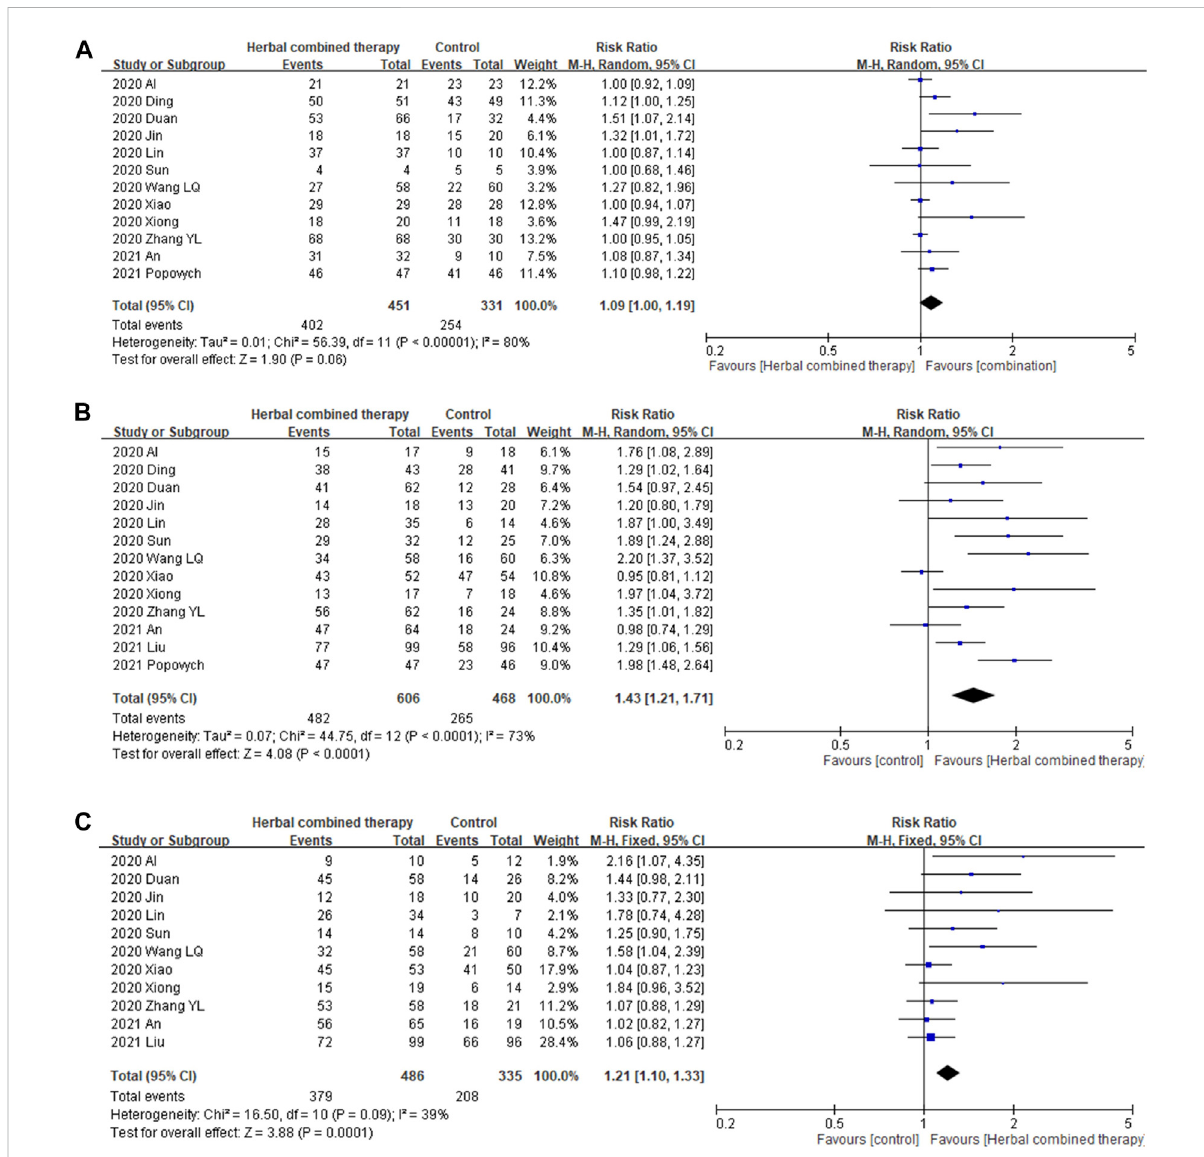
FIGURE 4 Forrest plot of the effects of HM combined therapy in symptom relief. (A) : comparison of HM combined therapy in fever reduction. (B) : Comparison of HM combined therapy in cough reduction. (C) : Comparison of HM combined therapy in fatigue reduction.